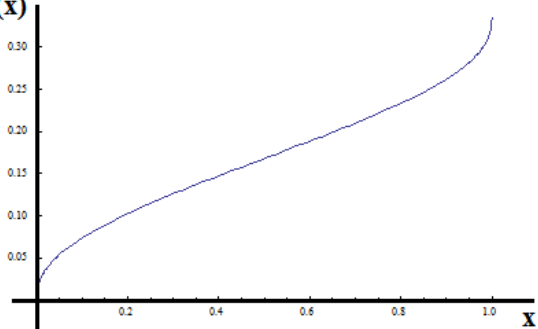
Figure 9. The non-dimensional displacement of the symmetric fractional fractal bar of order γ = 0.80.